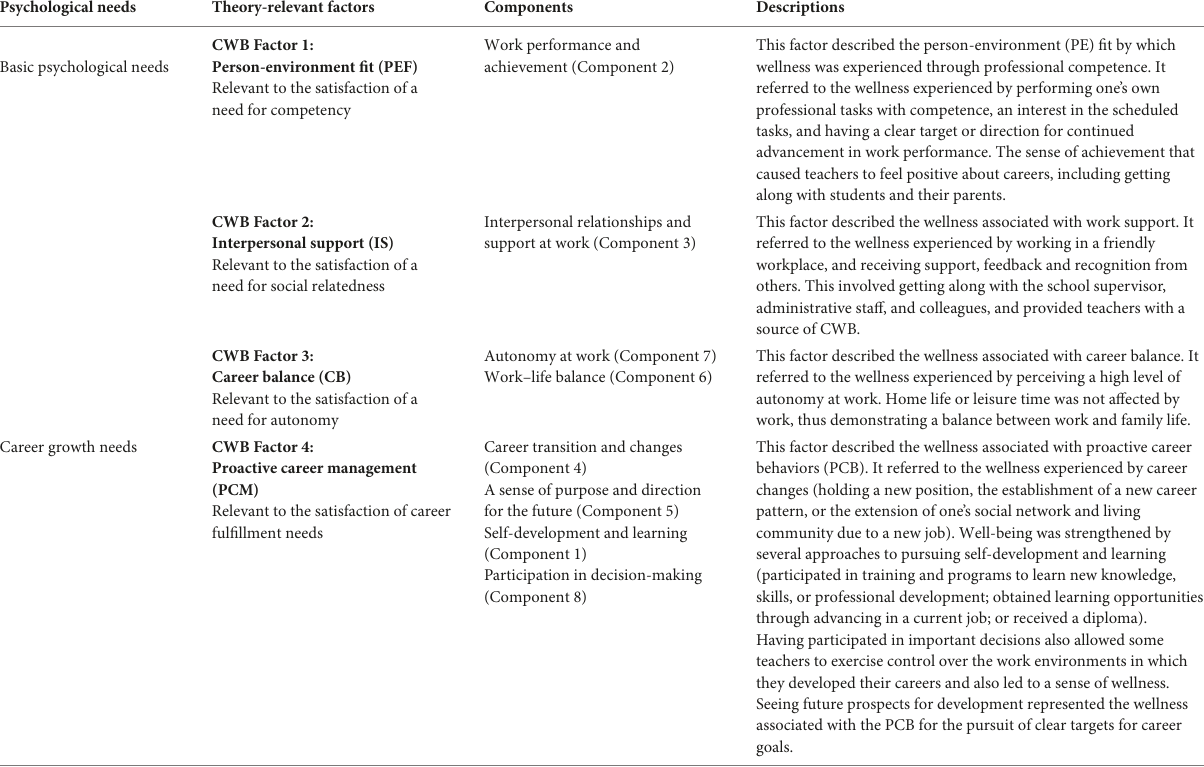
TABLE 2 A conceptualization of